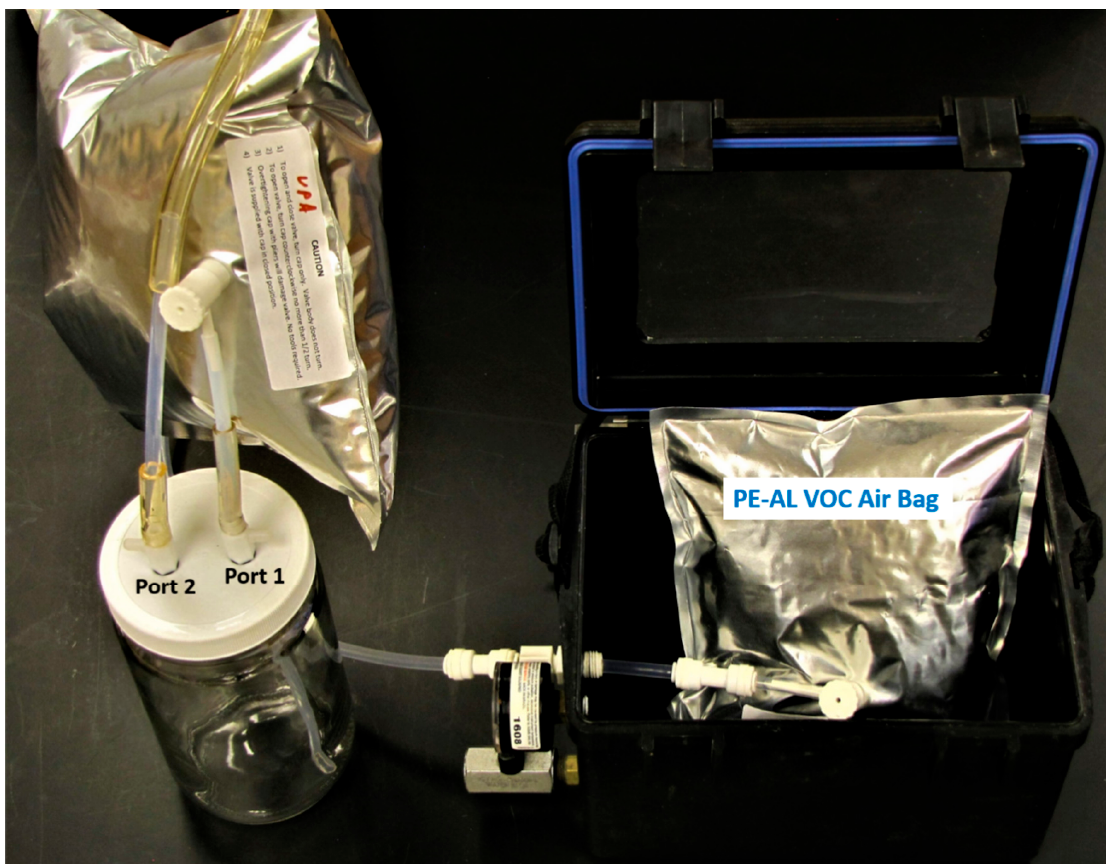
Figure 1. Bat VOC air-collection apparatus assembly. Xitech vacuum chamber (at right, containing PE-AL VOC air-sampling bag inside) with glass bat air-sampling chamber (at left) connected via two port valves to FEP tubing with Port 1 (receiving air inflow from pure zero-air replacement bag), and Port 2 (allowing outflow of bat sample air to input port of Xitech air-collection chamber and internal VOC air-collection bag).